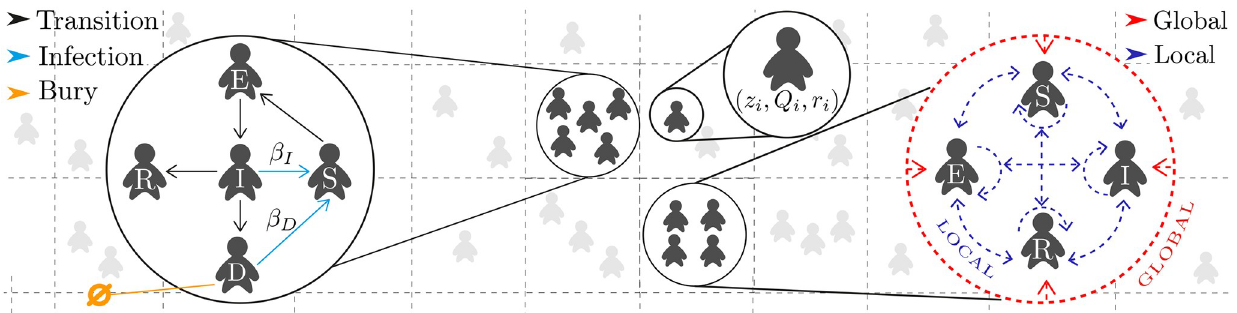
Fig 1. Graphical scheme of our agent-based model. The dynamics of the spreading of the infectious disease is depicted in the left side, where β represent the infection rate of infected agents and dead agents, respectively. Black lines represent deterministic transitions, in days, between states. Blue lines represent infections and, in orange, agents that get buried or removed from the system. The dynamics of information transfer between agents (local communication) is depicted in the right side using blue dashed lines. Information coming from a central entity to the population (global communication), is represented by red dashed lines. Each agent i in the middle zoomed circle is defined by a vector ( z i , Q i , r i ) where the set of parameters represent its position in the space, its epidemiological state and its information state, respectively. The physical space representation, where each square represent a patch and the shaded agents represent a sample of agents distributed in space, is represented by gray discontinued lines in the background.